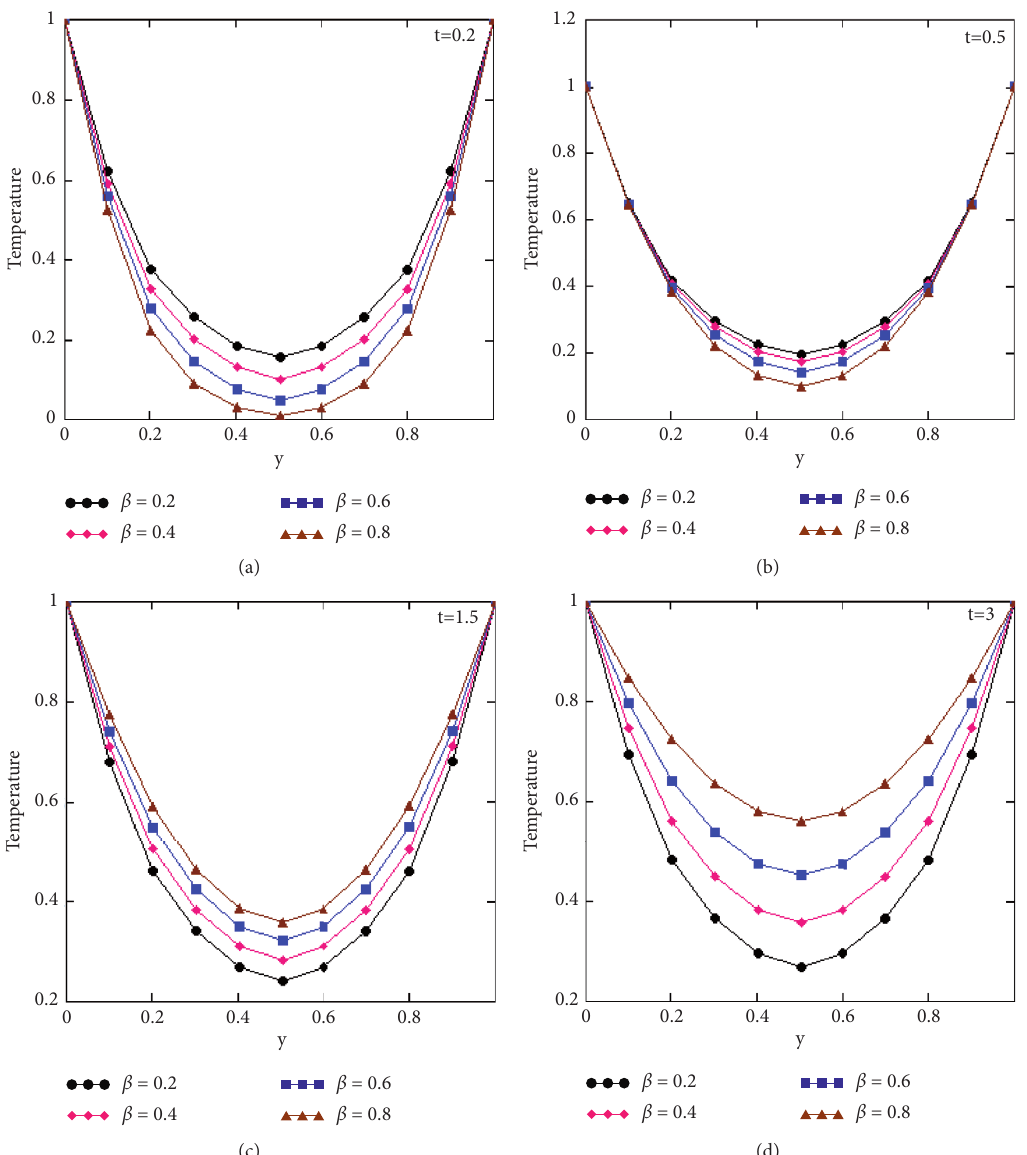
Figure 3: Profiles of dimensionless temperature versus y for variation of β at altered values of time t , Pr � 20and Q � 0 . 5, and ( t ) � H ( t ) � f ( t ) f 1 2